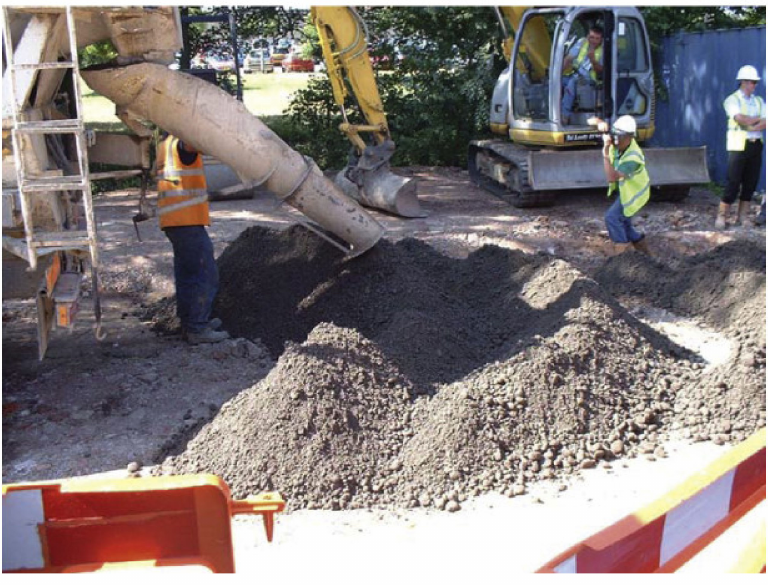
Figure 2. Semidry concrete for a road foundation. Reproduced from